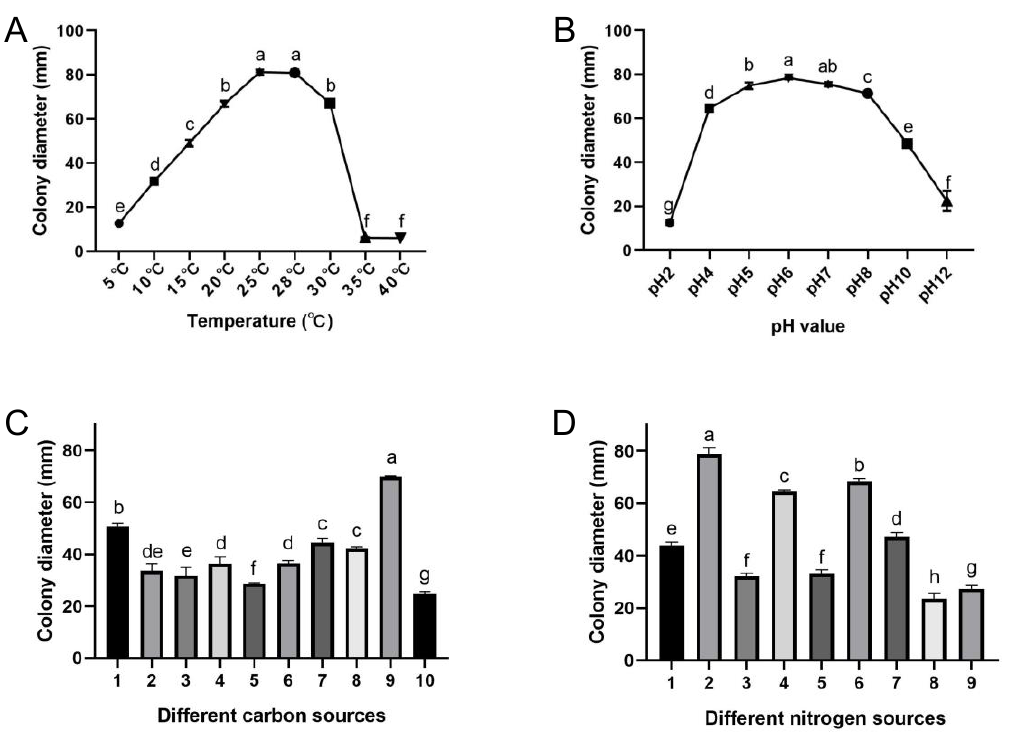
Figure 6. Optimization of culture condition for S. tainanensis SF007. ( A , B ) used PDA medium as the test medium; ( B , C ) used Czapek-Dox agar medium as the replacement medium. ( A ). Effect of temperature on mycelial growth. ( B ). Effect of pH on mycelial growth. ( C ). Effect of different carbon sources on mycelial growth; 1, corn meal; 2, D-mannitol; 3, glucose; 4, glycerin; 5, sucrose; 6, maltose; 7, soluble starch; 8, maltodextrin; 9, oats; 10, sources without carbon. ( D ). Effect of different nitrogen sources on mycelial growth; 1, tryptone; 2, yeast extract; 3, NaNO 3 ; 4, casein acid hydrolysate; 5, KNO 3 ; 6, beef extract; 7, NH 4 NO 3 ; 8, urea; 9, sources without nitrogen. Means were compared by Duncan’s test, and different letters above each bar indicate a significant difference at p ≤ 0.05. Data are presented as the mean ± SD of three replicates.